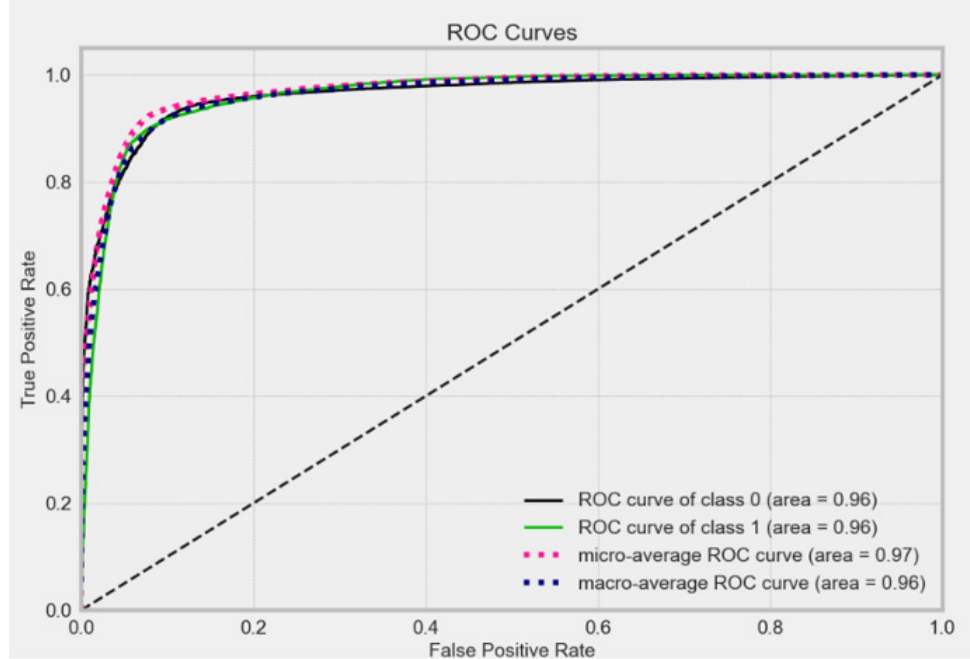
Figure 13. ROC Curves for LightGBM model.